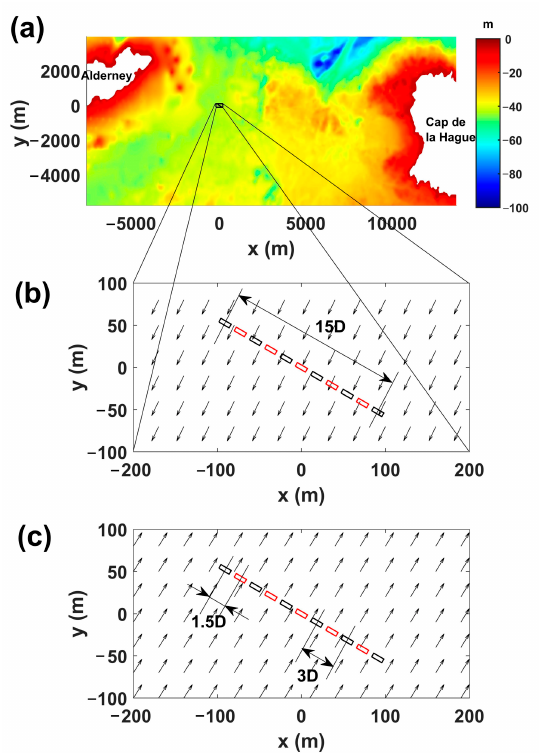
Figure 1. ( a ) Bathymetry of the study site with location of the fence of turbines. Depth-averaged current direction during peak ( b ) ebb and ( c ) flood of a mean spring tide. The lateral spacing (center to center) are indicated in number of turbine diameters D . For a lateral spacing of 1.5 D , 11 turbines are active. For a lateral spacing of 3 D , only the 6 turbines represented in black are active. The origin of the coordinates system (in meters) corresponds to the center of the fence of turbines (49°42.300 ′ N; 2°6.180 ′ W).